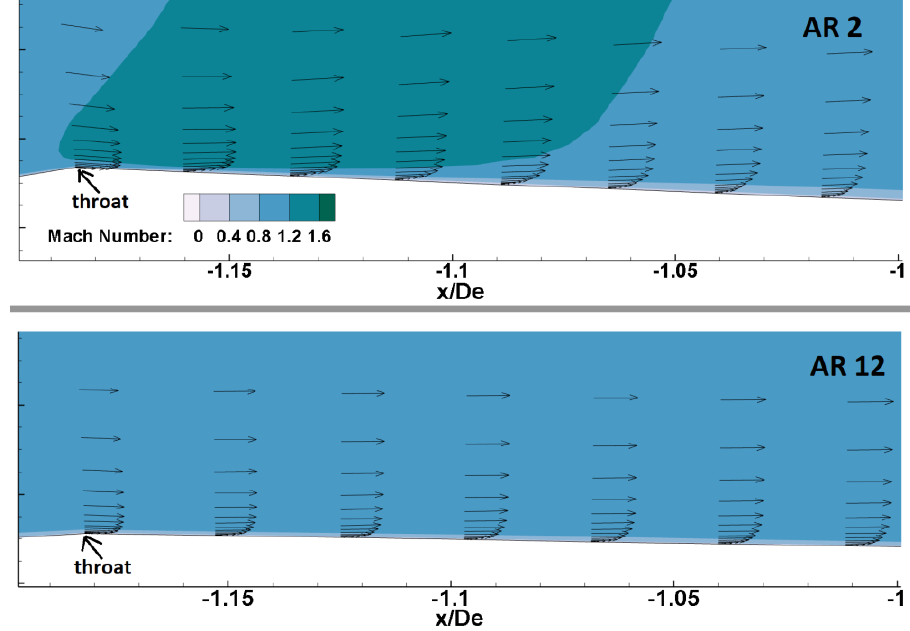
Figure 4. Boundary layer growth from the throat to downstream in AR2 and AR12 nozzle on minor axis symmetry plane.